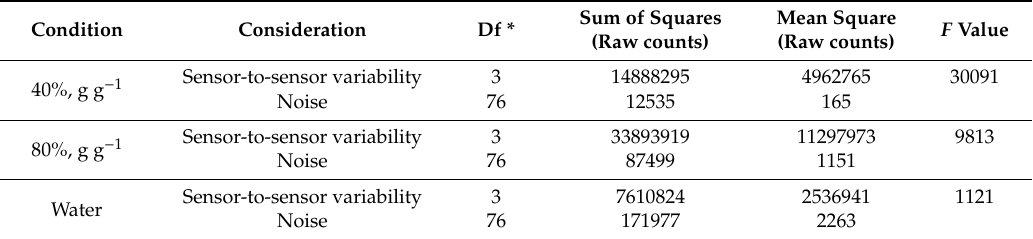
Table 2. Results of the ANOVA test for 20 replications of sensor response measurements of 4 SKU:SEN0193 sensors for 3 di ff erent